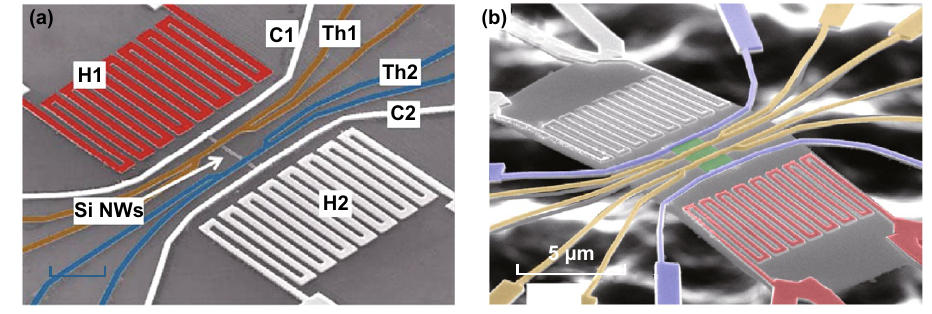
Fig. 14 SEM images of a non-suspended thermoelectric micro-device platform and b suspended thermoelectric micro-device platform. Repro- duced with permission from Ref. [235]. Copyright 2008, Springer